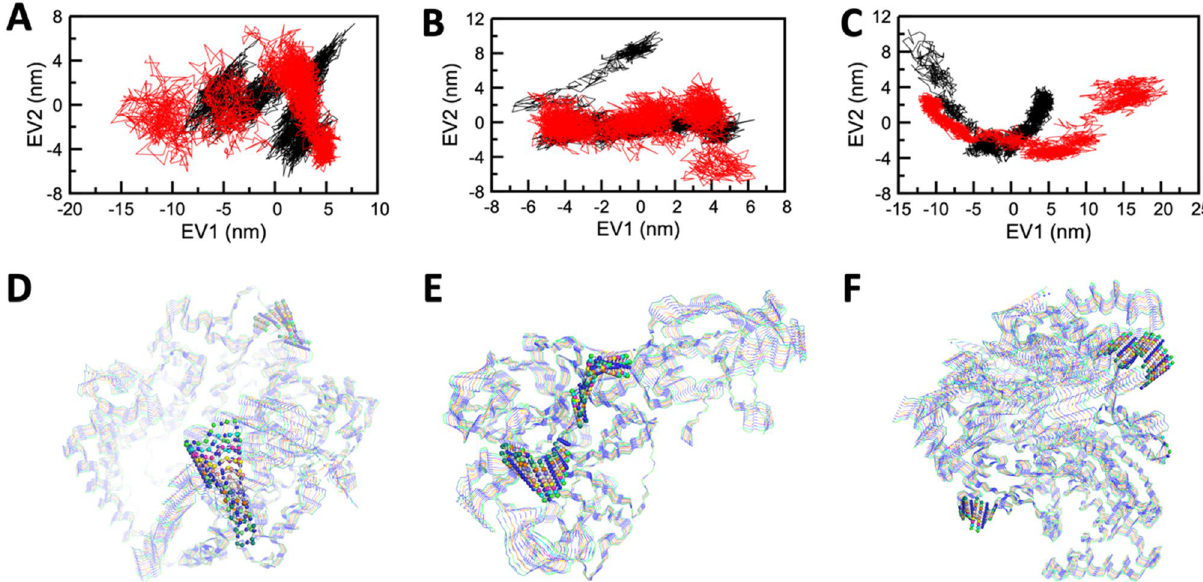
Figure 6. Projection of the motion of the apo and holo forms of ACE2, TMPRSS2, and RdRP in phase space along the first two principal eigenvectors (EV1 and EV2) for ( A ) ACE2 ( B ) TMPRSS2 and ( C ) RdRP. Graphical representation of 10 equally divided structures extracted from dynamic trajectories showing prevalent motions in ( D ) ACE2 ( E ) TMRRSS2 and ( F ) RdRP. Residues found to be highly mobile in comparison to other residues in the targeted proteins depicted in the ball and stick